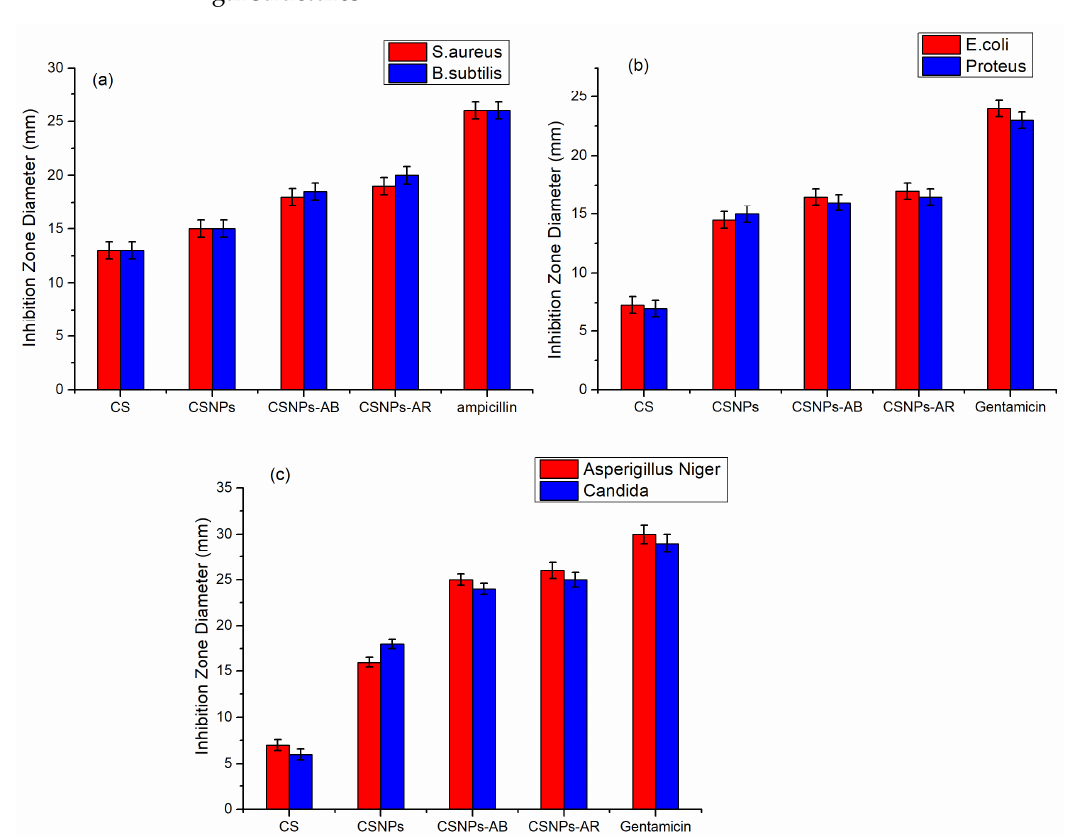
Figure 10. Antimicrobial activity of cotton fabrics treated with chitosan (CS), chitosan nanoparticles (CSNPs), and chitosan nanoparticles dyed Acid Blue 317 and Acid Red 88 against: gram-positive bacteria ( a ), gram-negative bacteria ( b ), and fungi ( c ).